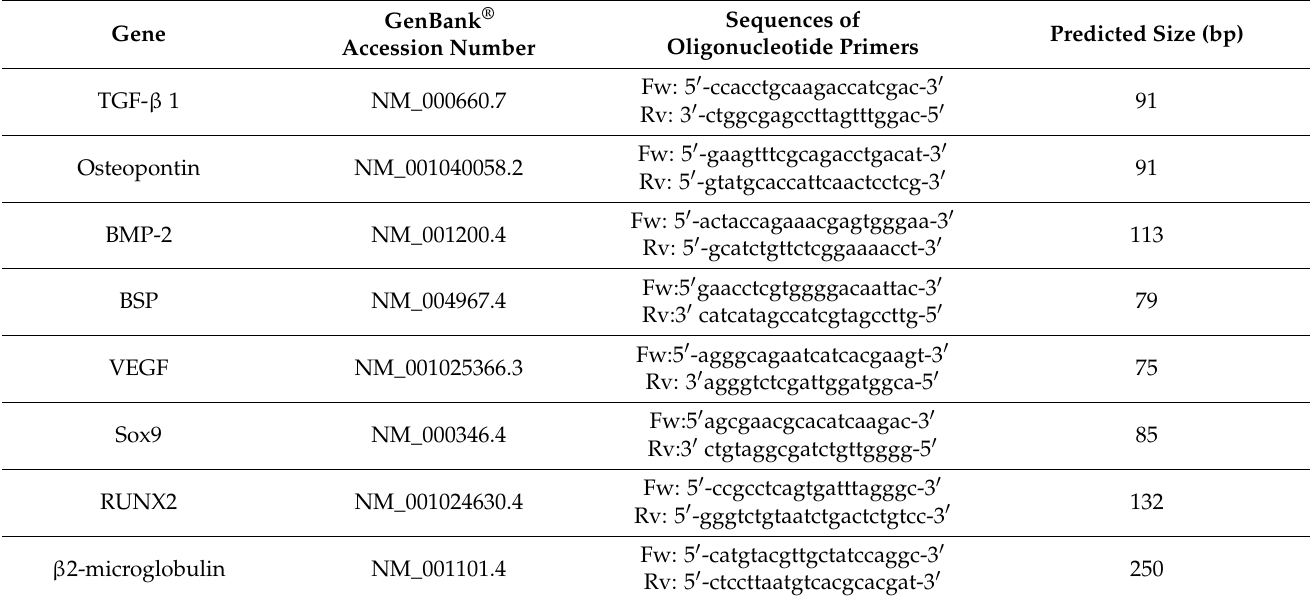
Table 1. The sequences of oligonucleotide primers used for evaluation of gene